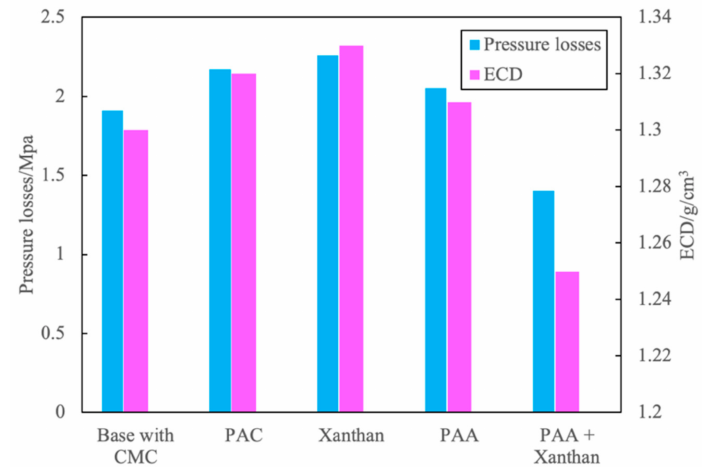
Figure 4. Calculation of ECD using various washing fluid